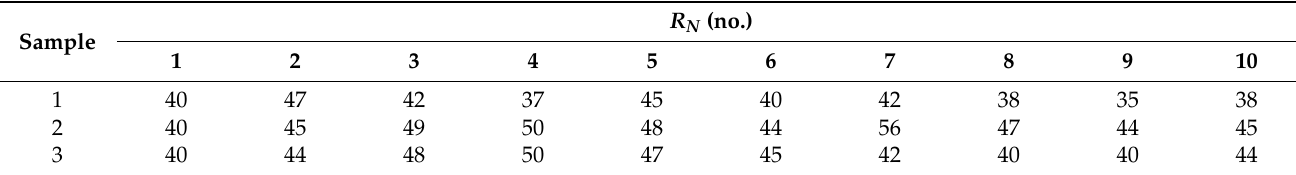
Table 8. Corrected results of the Schmidt hammer test on travertine.